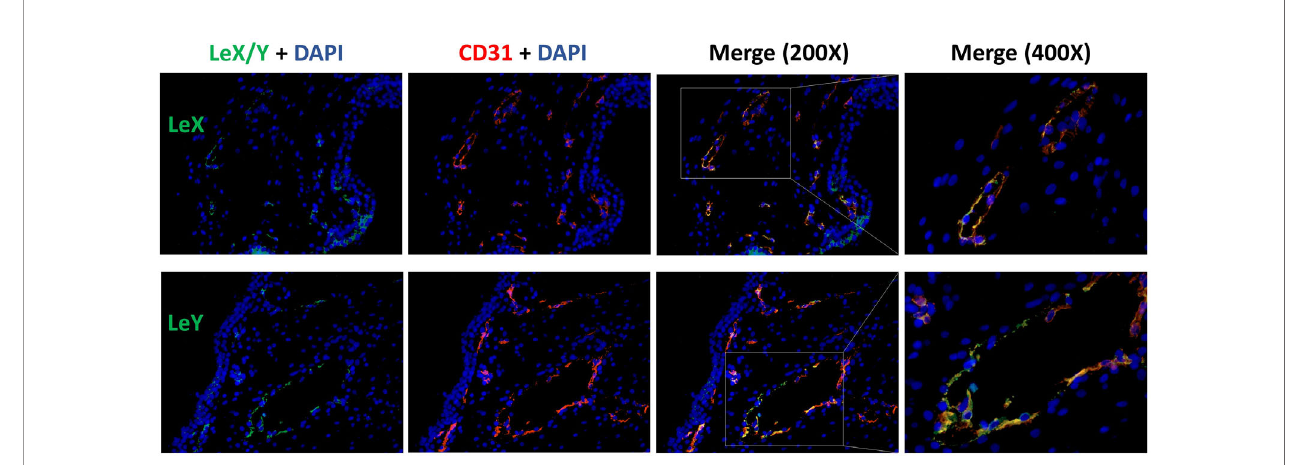
FIGURE 8 | Immuno fl uorescent double staining of LeX/Y + CD31 in the endothelial cells of villous